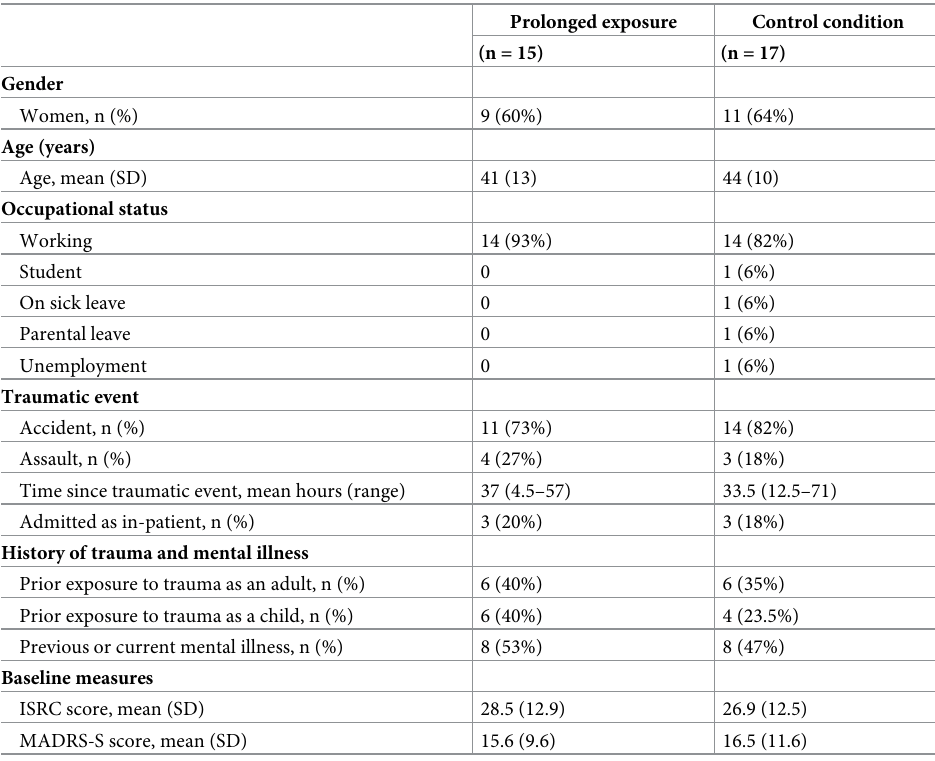
Table 1. Baseline characteristics for included participants by intervention condition.